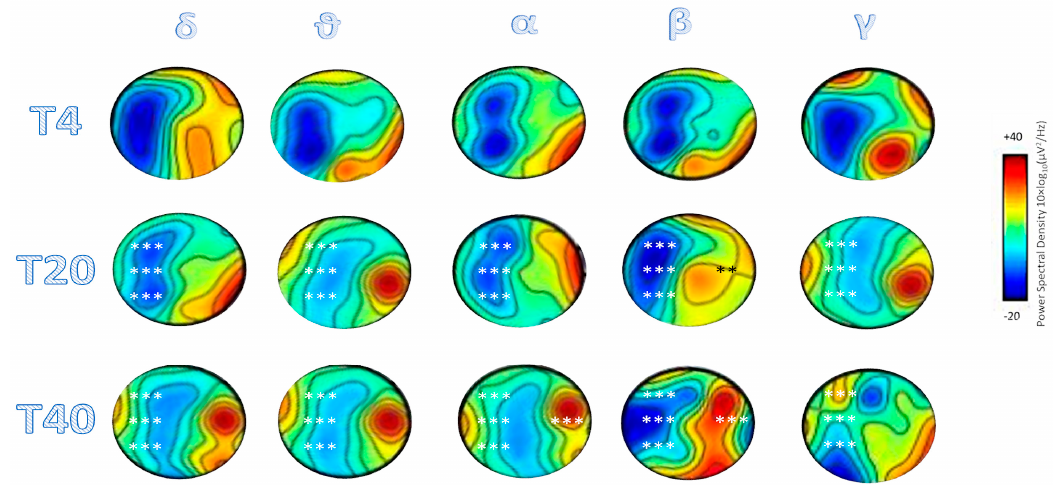
Figure 3. The scalp maps of event-related desynchronization/synchronization (ERD and ERS) across